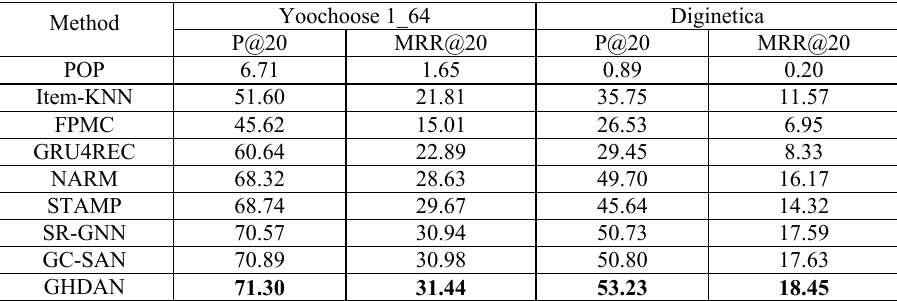
Table 2. Performances of different methods on the two